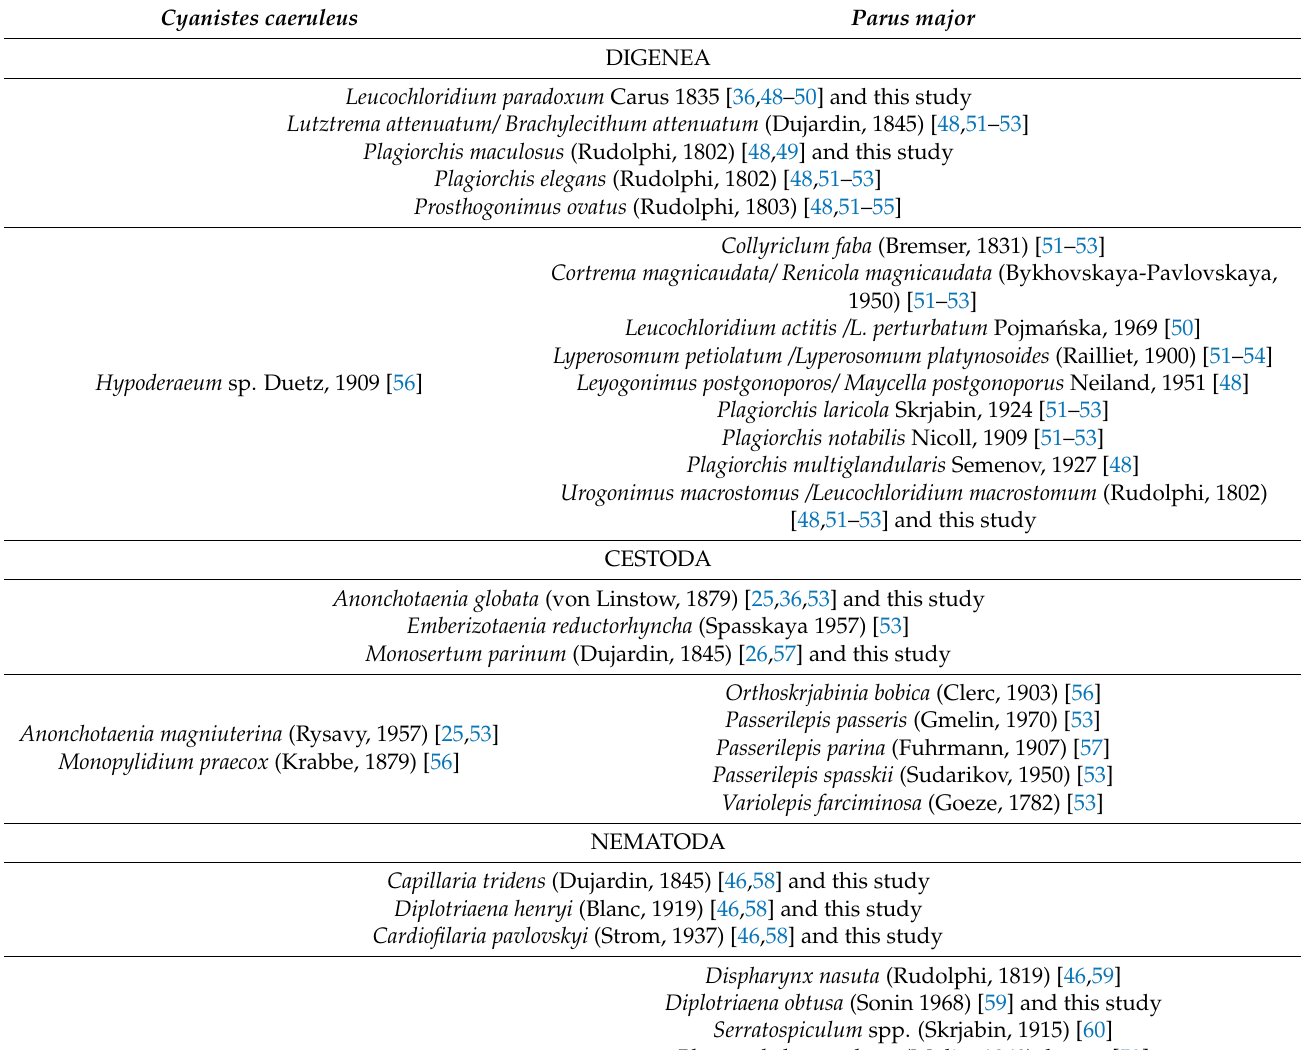
Table 4. Helminths recorded in Eurasian blue tit Cyanistes caeruleus and in Great tit Parus major . A slash (/) between species names indicates